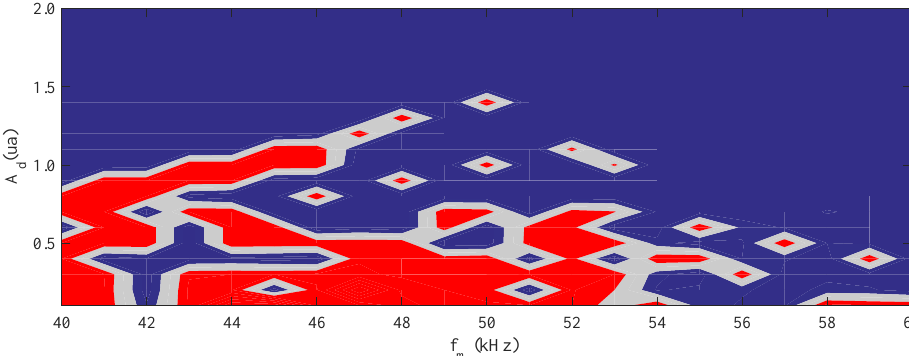
Figure 6. Color map of the different emission regimes of the laser, based on the influence of the bias signal. The red area corresponds to P 2 , the blue area corresponds to P 1 , and the gray area corresponds to an undefined